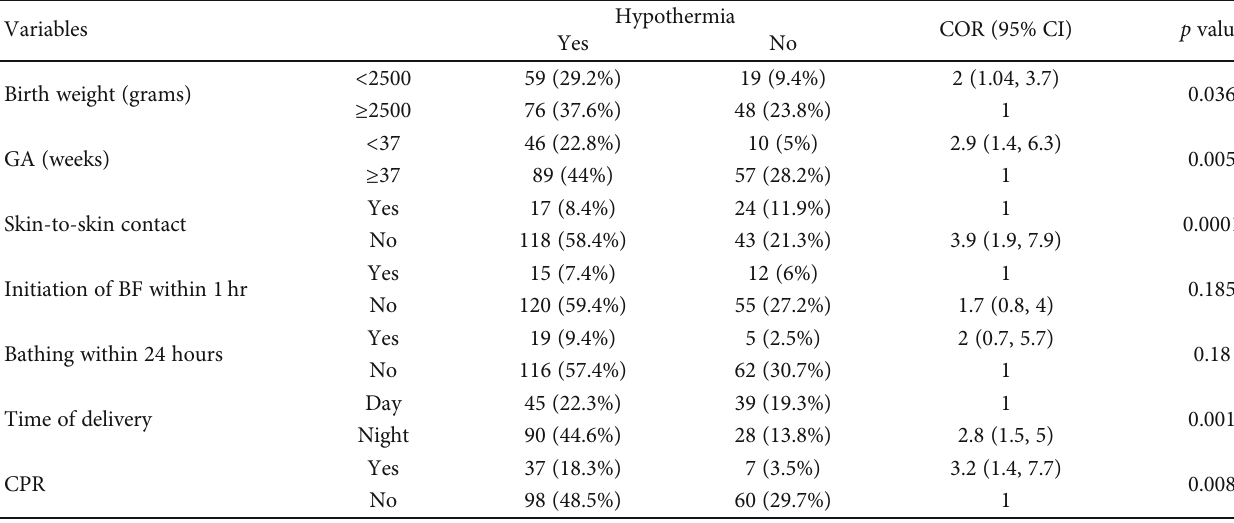
Table 4: Bivariate logistic regression analysis of factors associated with neonatal hypothermia in the NICU of Dessie Referral Hospital, Ethiopia, 2018 ( N = 202 ).